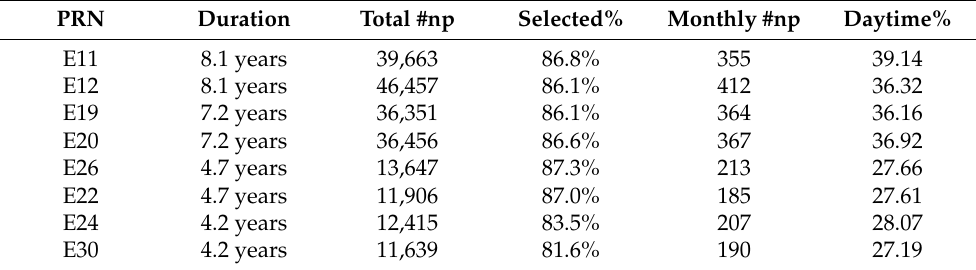
Table 4. Statistical SLR tracking information for Galileo satellites, as of 31 December 2019. Each column of the table represented the satellite PRN, duration of SLR observation, total number of normal points for all sites, proportion of selected site observations, monthly average of selected site observations, and proportion of daytime observations at selected